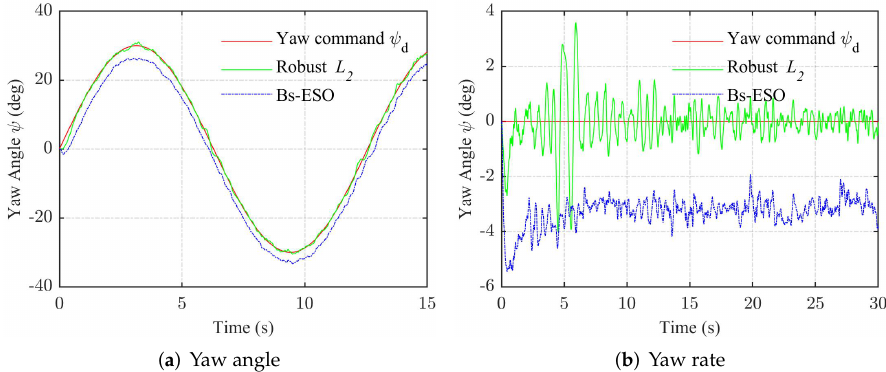
Figure 9. Performance at suppressing the internal disturbances.